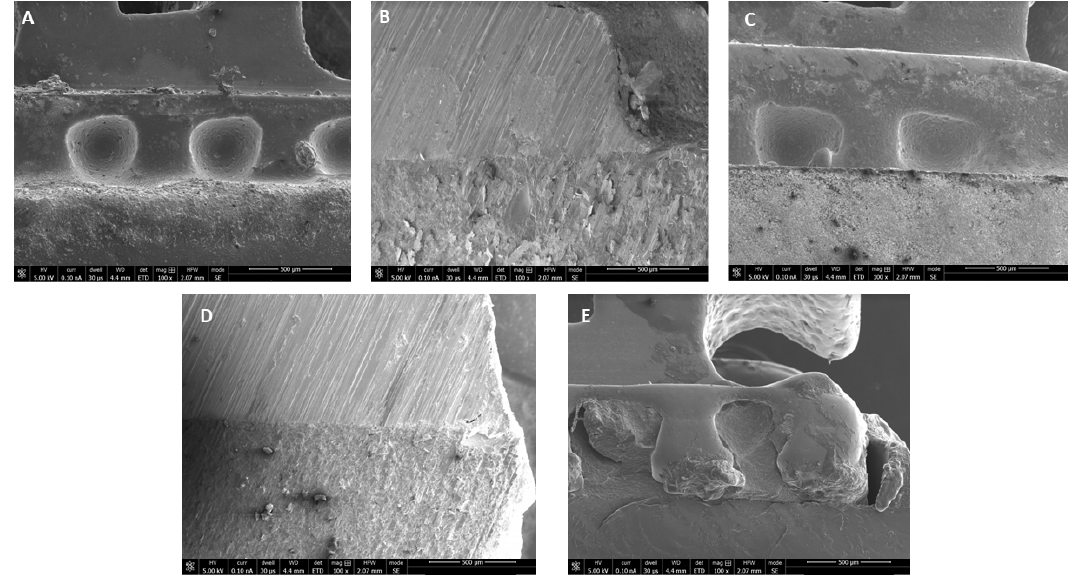
Figure 2. Representative SEM images of bracket-resin interface depicting excellent bonding of tooth surface with ( A ) Transbond XT (control); ( B ) 0.1% RB-PDT adhesive; ( C ) 0.1% RF-PDT adhesive; and ( D ) 0.5% RB-PDT adhesive; but ( E ) 0.5% RF-PDT adhesive, showed slightly poor bonding with defective adhesive within the mesh of the bracket.